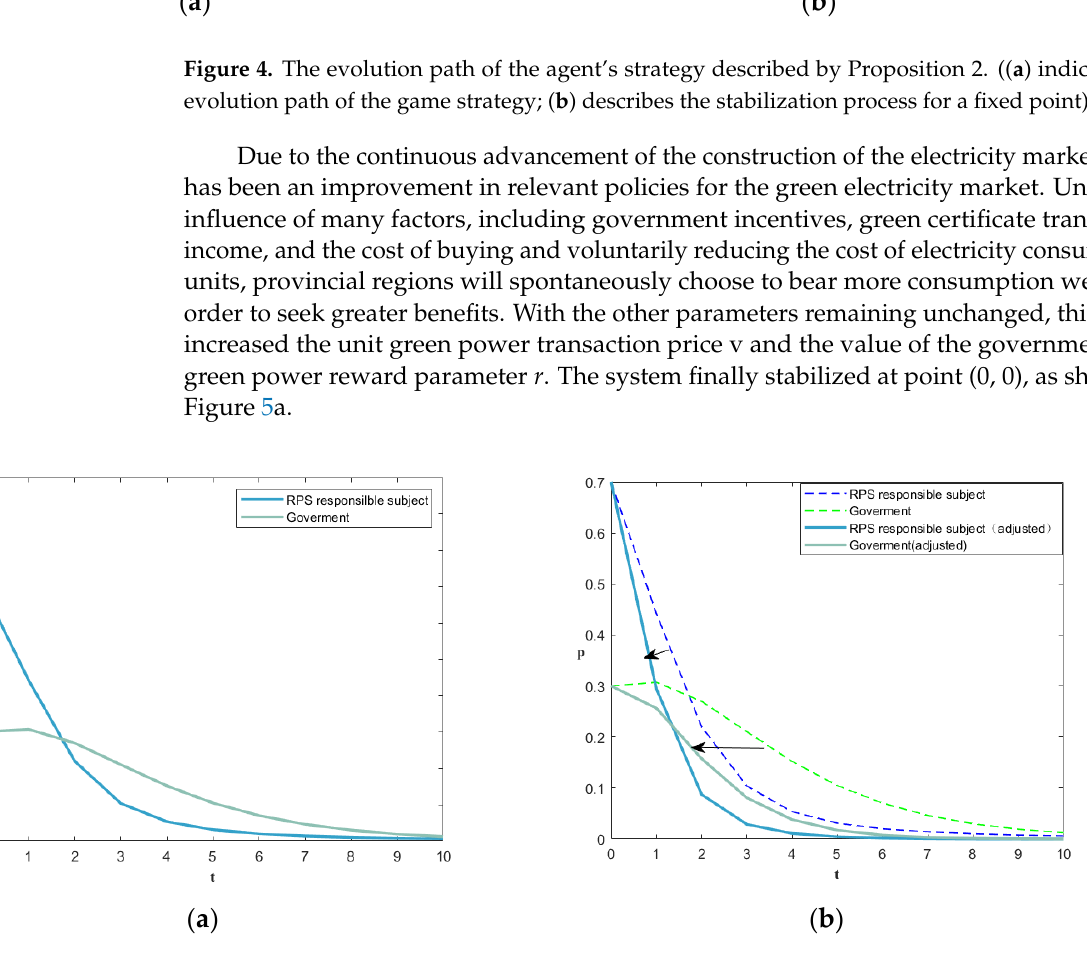
Figure 5. The strategic evolution path of the game entity and the changes after adjusting the param- eters ( 𝜋 1 > 0 ). (( a ) indicates the evolution path of the game strategy; ( b ) describes the impact of parameter changes on the evolution path of the game strategy).